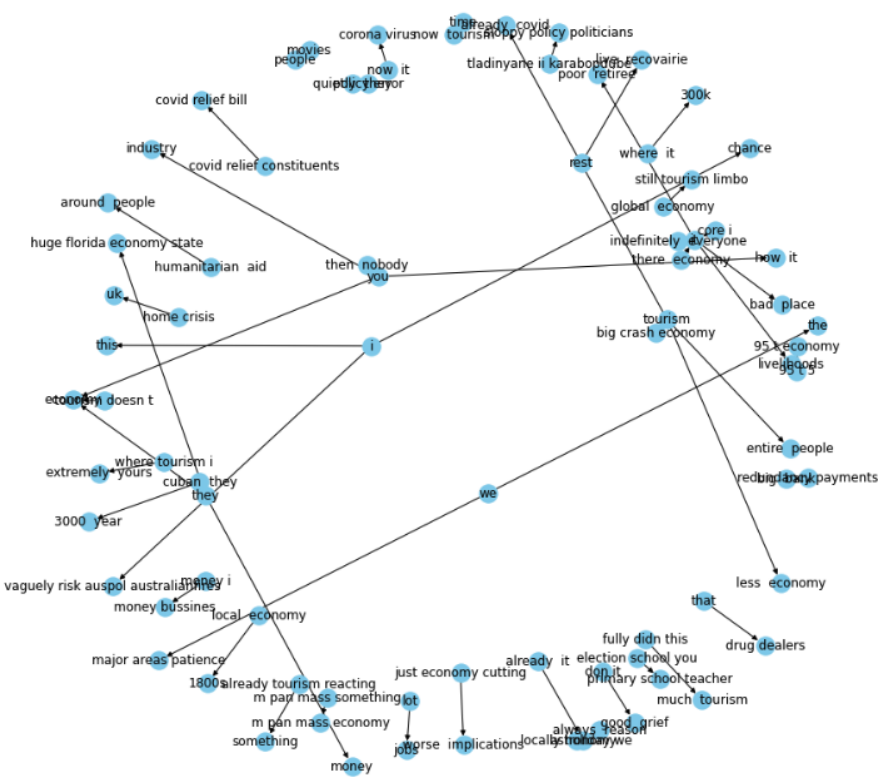
Figure 21. Knowledge Graph for Cluster 2.